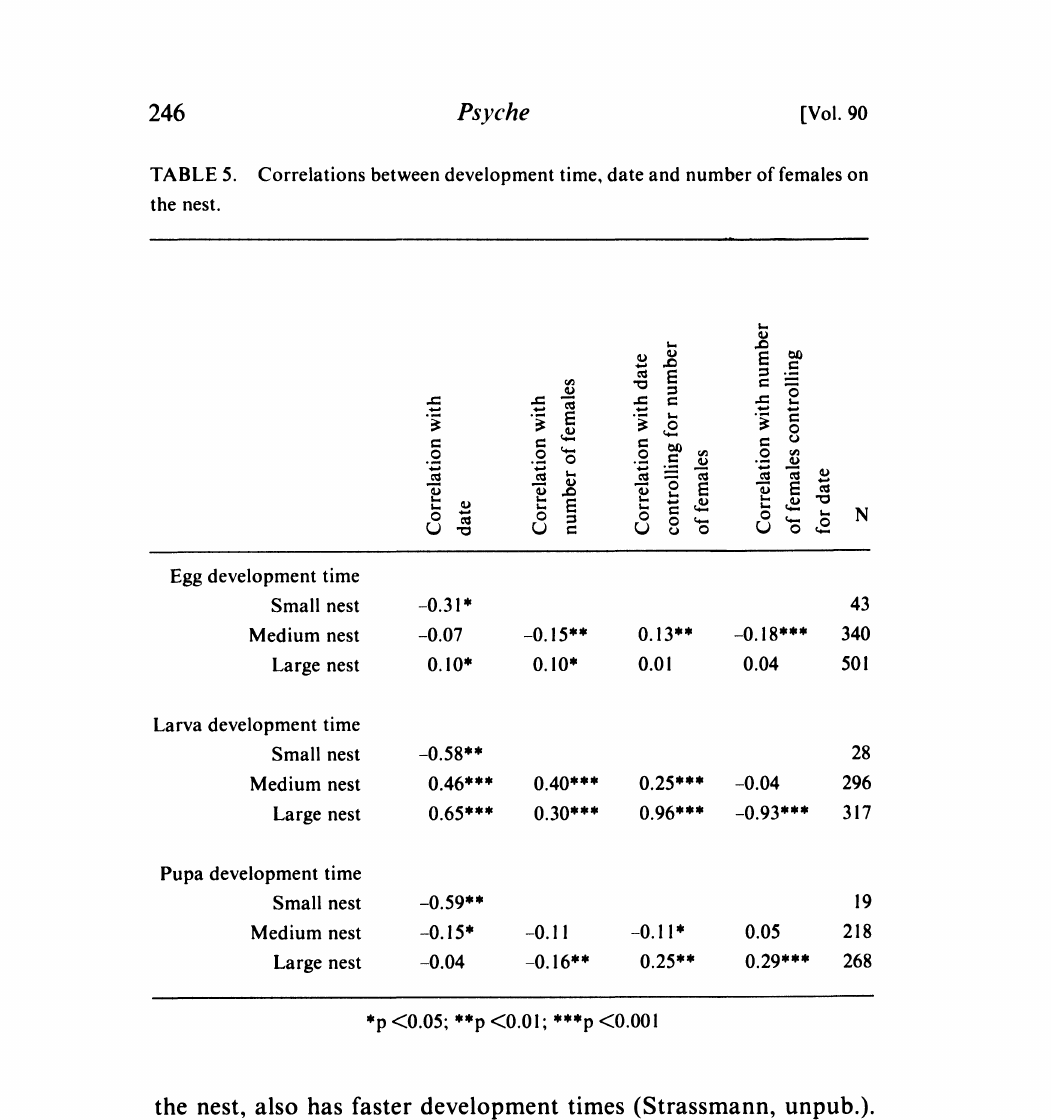
TABLE 5. Correlations between development time, date and number of females on the